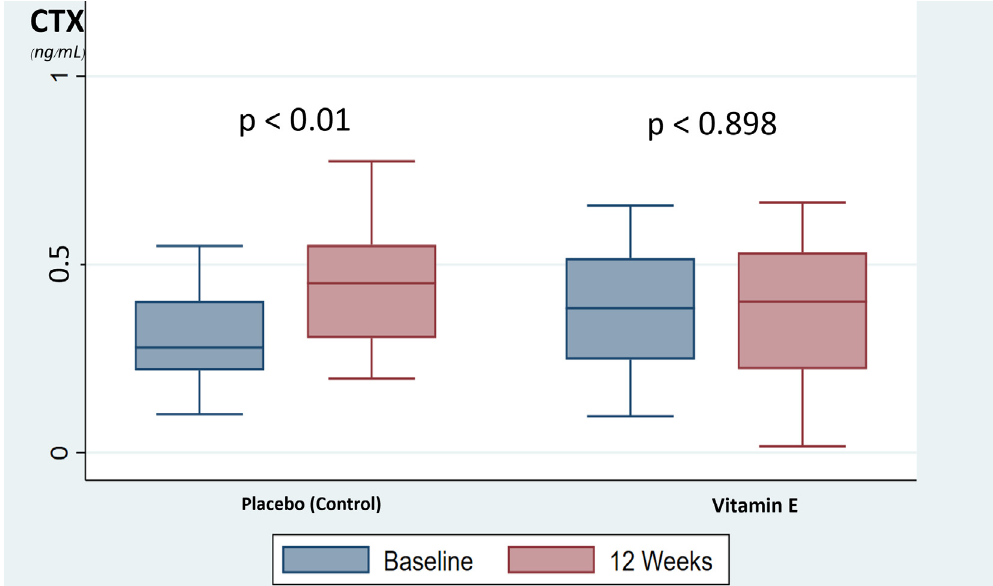
Figure 2 . The box - plot represents the changed of bone resorption marker . CTX, C - terminal telopeptide of type I collagen . Figure 2. The box-plot represents the changed of bone resorption marker. CTX, C-terminal telopeptide of type I